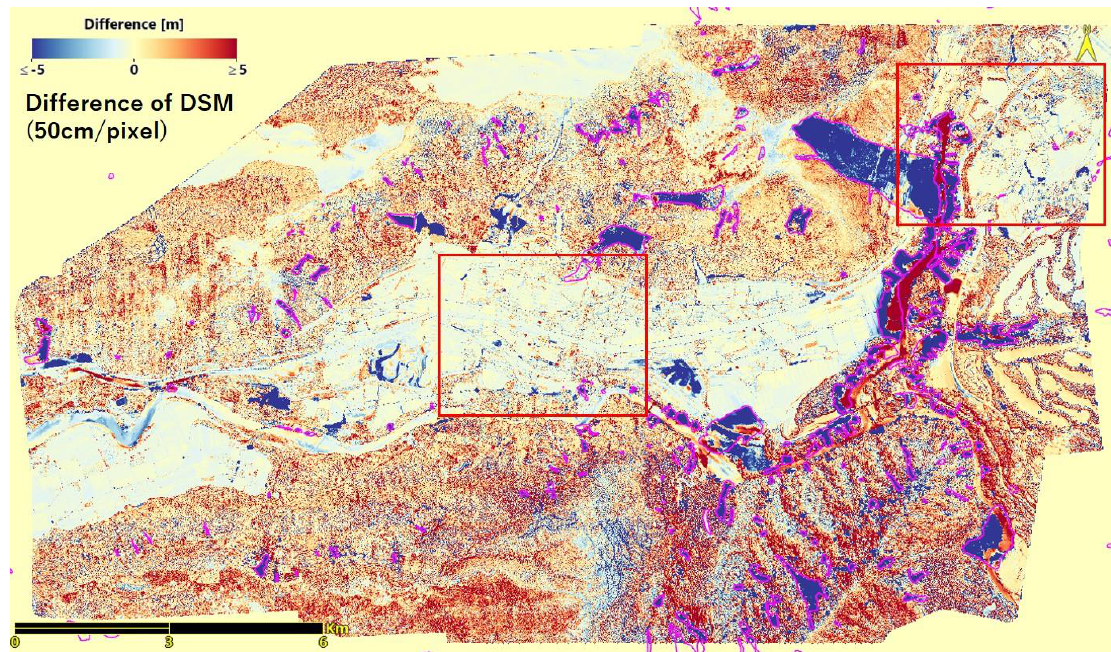
Figure 5. DSM difference in the co-event period (2013.1–2016.4) with pixel spacing of 0.5 m. Kawayo and Tateno districts are highlighted by red squares. Pink lines show the soil movement due to the earthquake detected by NIED